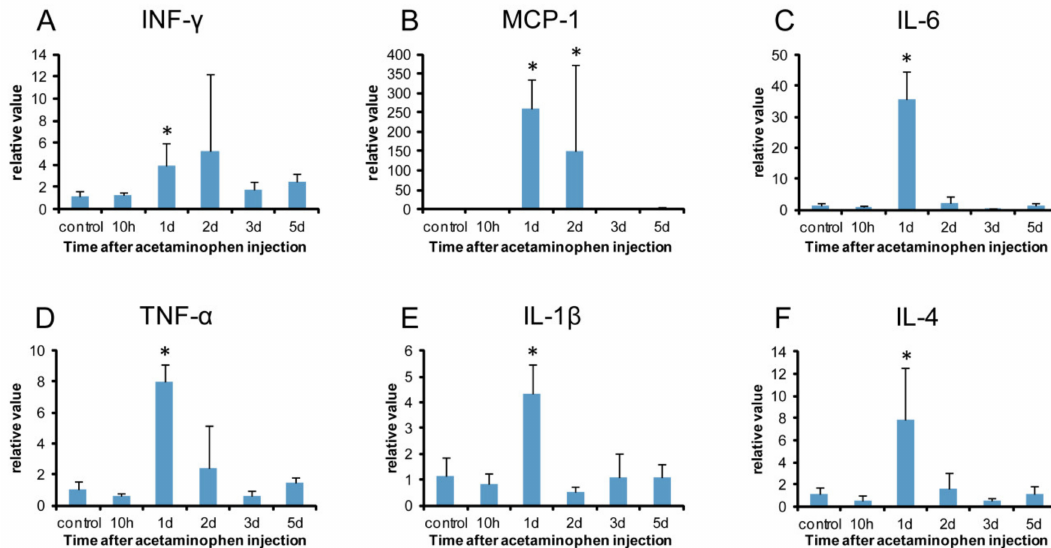
Figure 9. Expressions of mRNAs of M1 macrophage-related ( A-E ) and M2 macrophage-related ( F ) factors. Expression of mRNA levels of IFN- γ ( A ), IL-6 ( C ), TNF- α ( D ), and IL-1 β ( E ) show a significant increase on day 1 and that of MCP-1 ( B ) on days 1 and 2. Expression of mRNA level of IL-4 ( F ) significantly increase on day 1. Expression levels were normalized by the expression levels of 18s RNA. Dunnett’s test; *, significantly di ff erent from controls at p < 0.05. Bar represents the mean ±